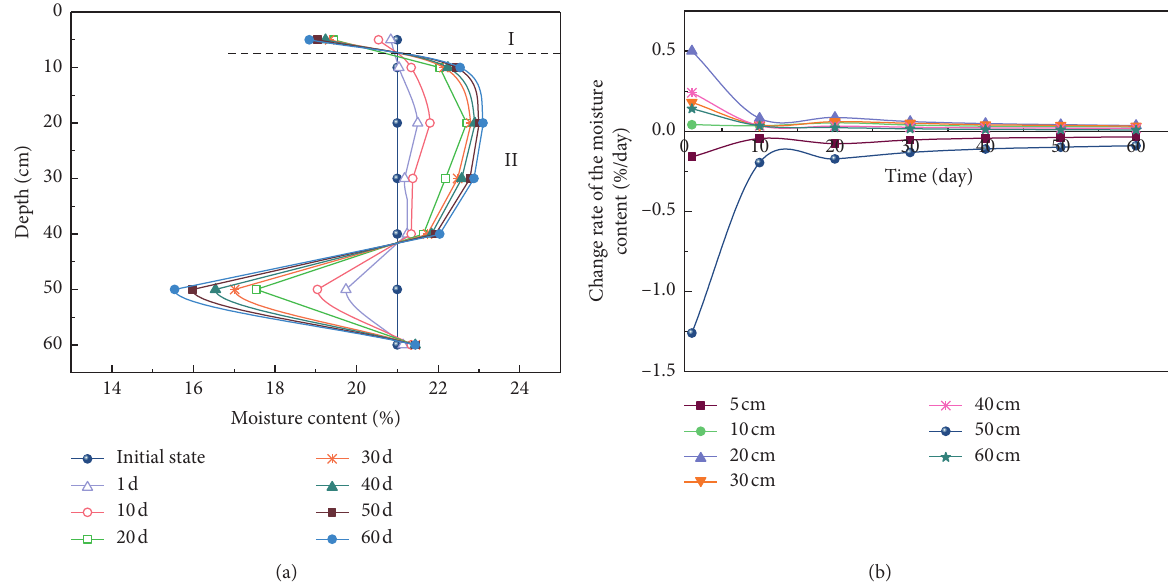
Figure 12: Influence of test time on moisture content distribution. (a) Moisture content variation with time. (b) Change rate of moisture content variation with